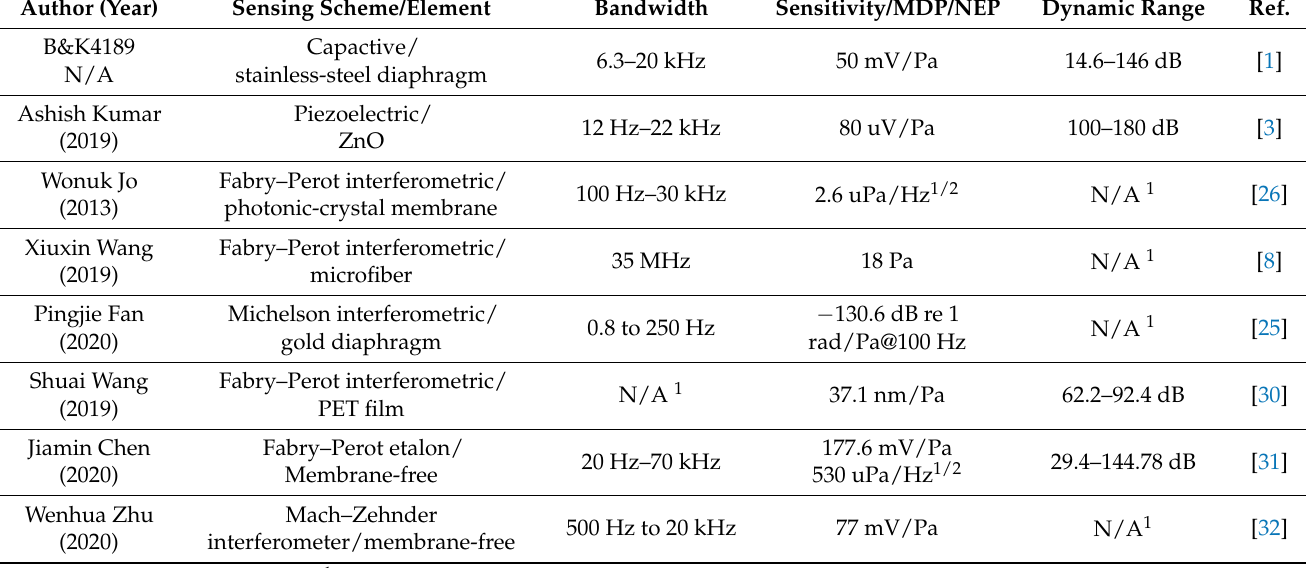
Table 1. Summary and comparison of the performance of acoustic